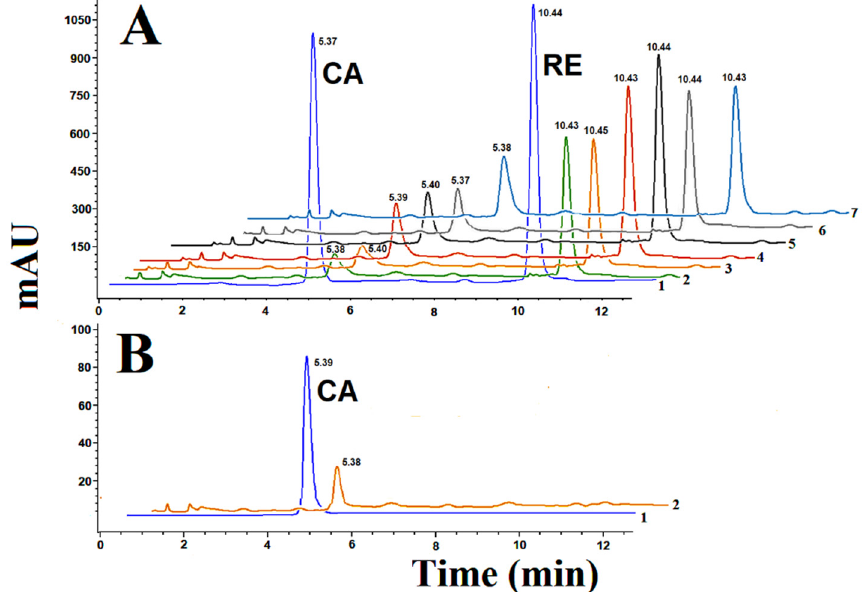
Figure 3. Synthesis of resveratrol (RE) from p -coumaric acid (CA) by recombinant strains of S. cerevisiae . ( A ) Mixture of authentic standards of p -coumaric acid and trans -resveratrol (1), biotransformation products of pESC-Pa4CL1-PhStS (2), biotransformation products of pESC-Pa4CL1- PcPKS5 (3), biotransformation products of pESC-Pa4CL1-MaSTS3 (4), biotransformation products of pESC-Pa4CL1-RtSTS (5), biotransformation products of pESC-Pa4CL1-VvVST1 (6), biotransformation products of pESC-Pa4CL1-AhSTS (7). ( B ) Authentic standard of p -coumaric acid (CA) and biotransformationof p -coumaricbywildtypeW303(2).Samplescollectedafter30hofbatchfermentation. Retention times are indicated for each